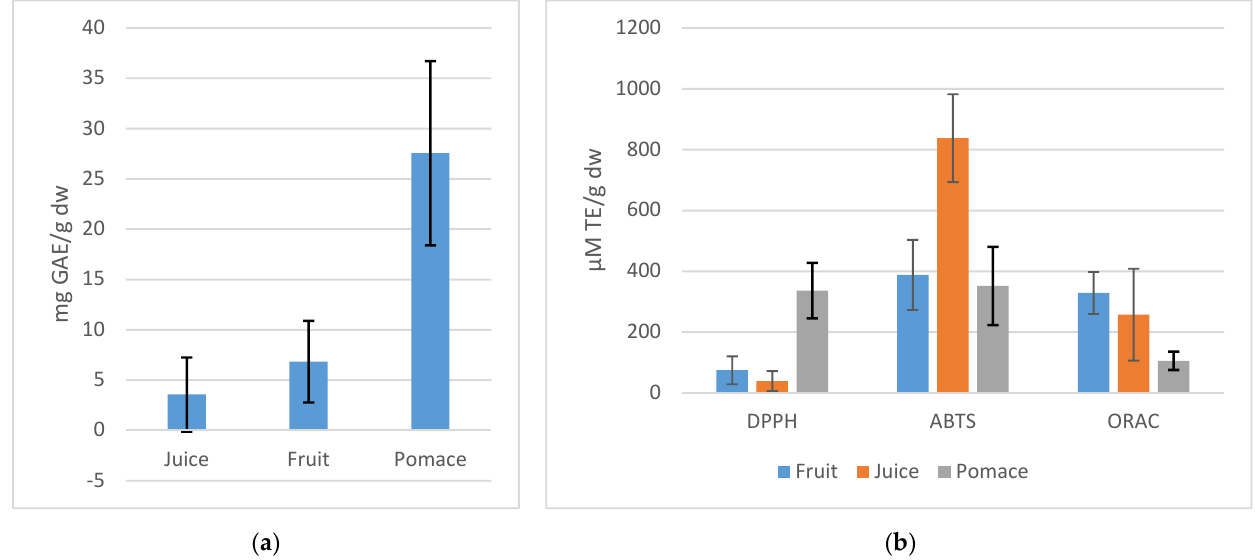
Figure 2. Mean values of TPC ( a ) and antioxidant capacity ( b ) of fruit, juice, and pomace of all cultivars in the current